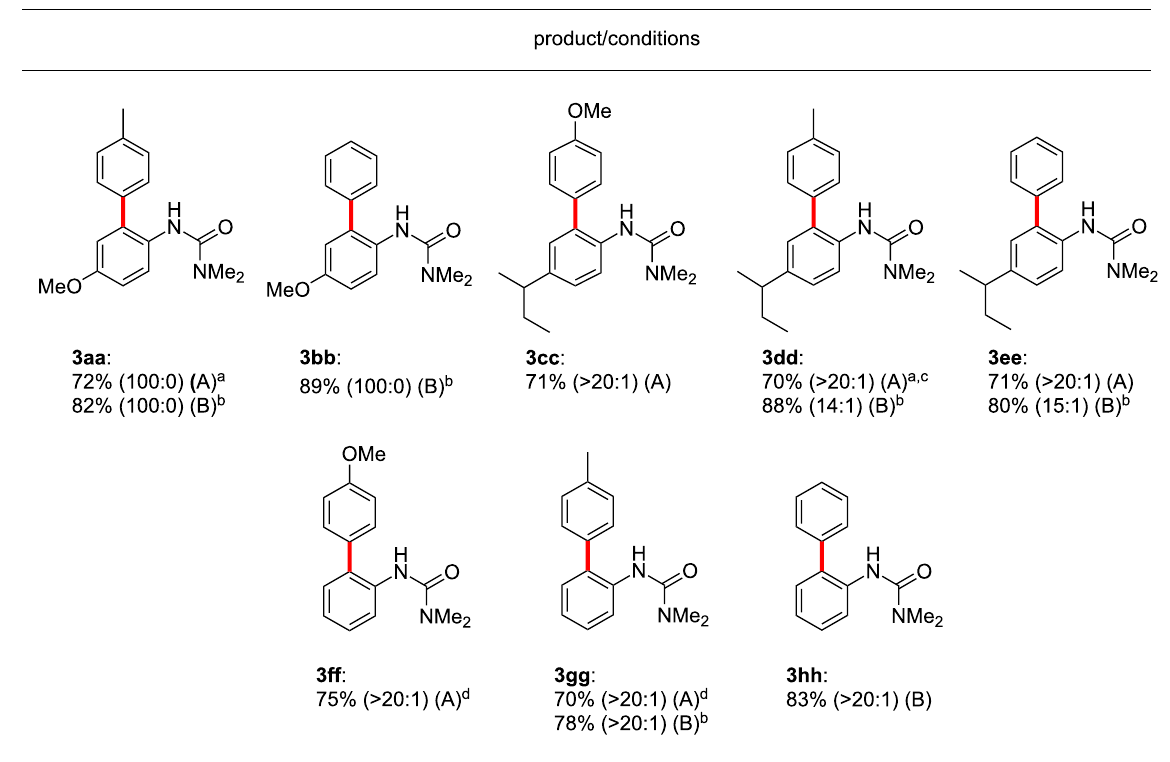
Figure 3: Monoarylations in water at rt. Conditions A: Conducted at rt for 20 h in 2 wt % Brij 35/water with 10 mol % Pd(OAc) 2 , AgOAc (2 equiv), HBF 4 (5 equiv), arylurea ( 1 , 0.25 mmol), and ArI ( 2 , 1.5 equiv). Conditions B: Conducted at rt for 20 h in EtOAc with 10 mol % [Pd(MeCN) 4 ](BF 4 ) 2 , BQ (5 equiv), arylurea ( 1 , 0.25 mmol), and ArB(OH) 2 ( 2 , 1.5 equiv). The ratios of single:double arylation determined by 1 H NMR are shown in the parentheses. a Run for 48 h. b 1.2 equiv of ArB(OH) 2 . c 1.2 equiv of ArI. d Run for 72